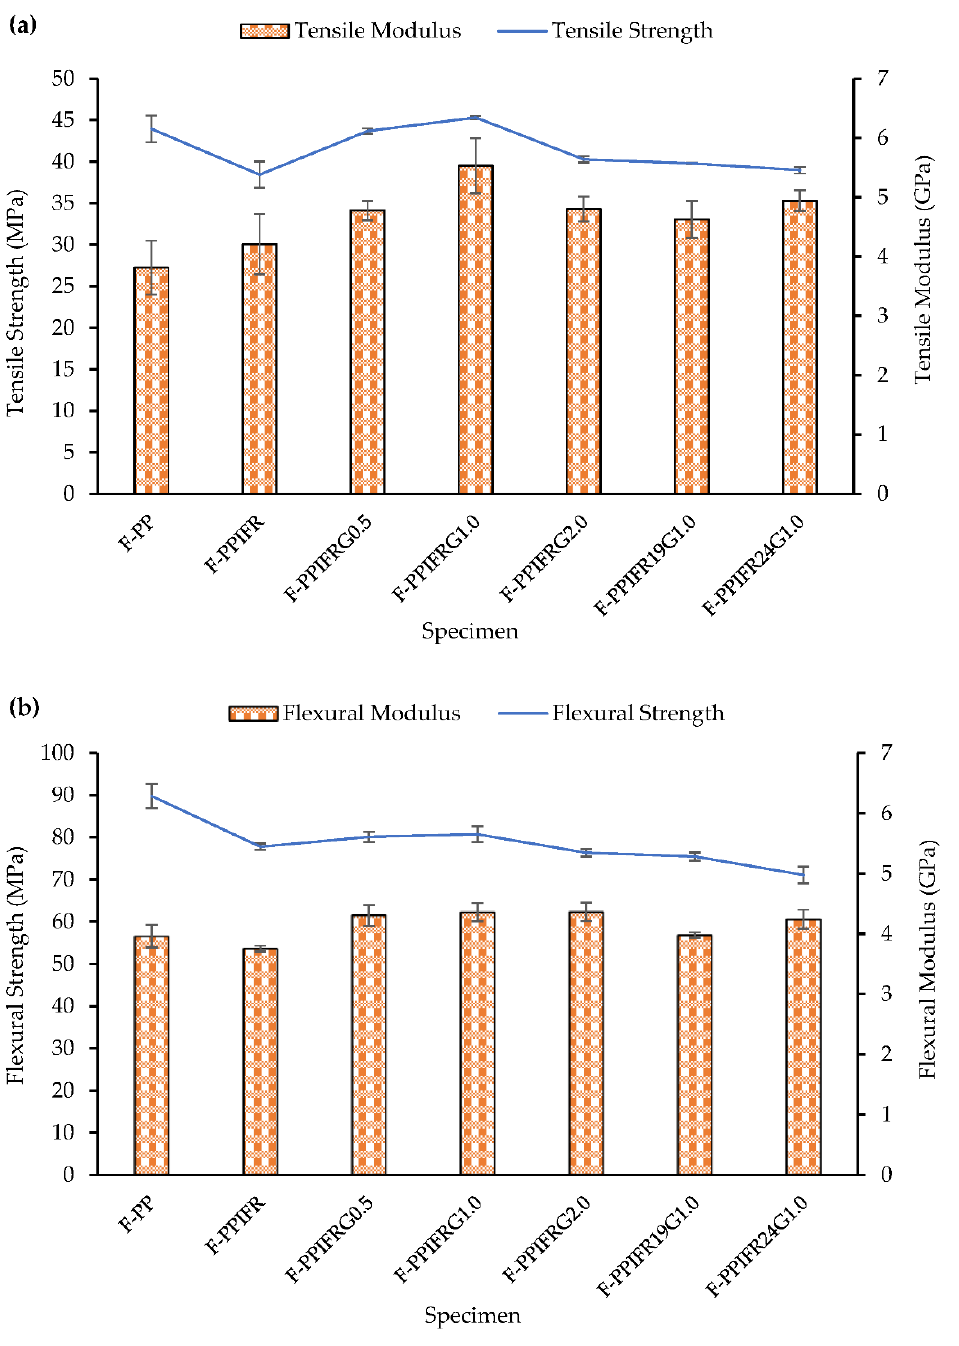
Figure 2. ( a ) Tensile and ( b ) flexural properties of